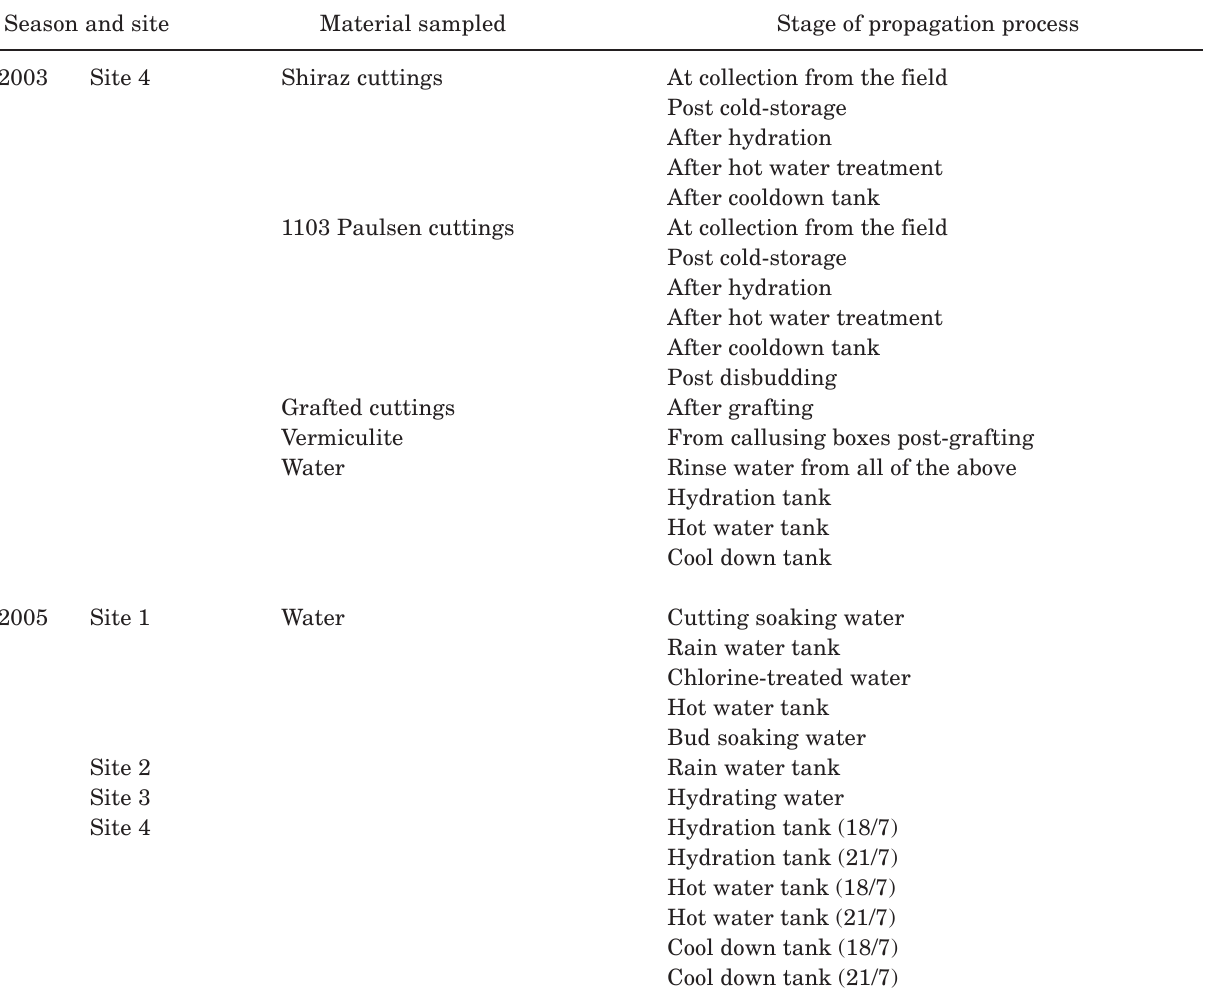
Table 1. Samples collected from commercial nurseries during the propagation seasons of 2003 and 2005. Season and